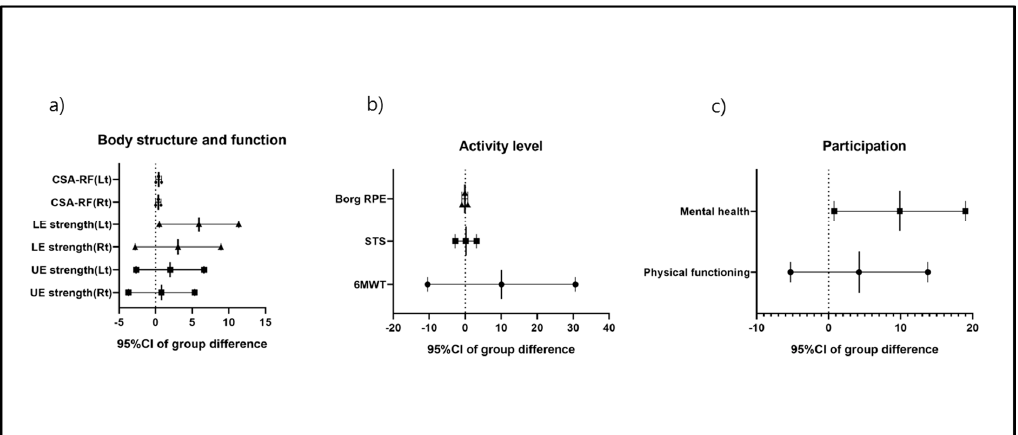
Figure 2. The means with 95%CIs of the between-group differences after the training. ( a ) Body function and structure, ( b ) activity level, and ( c ) participation.